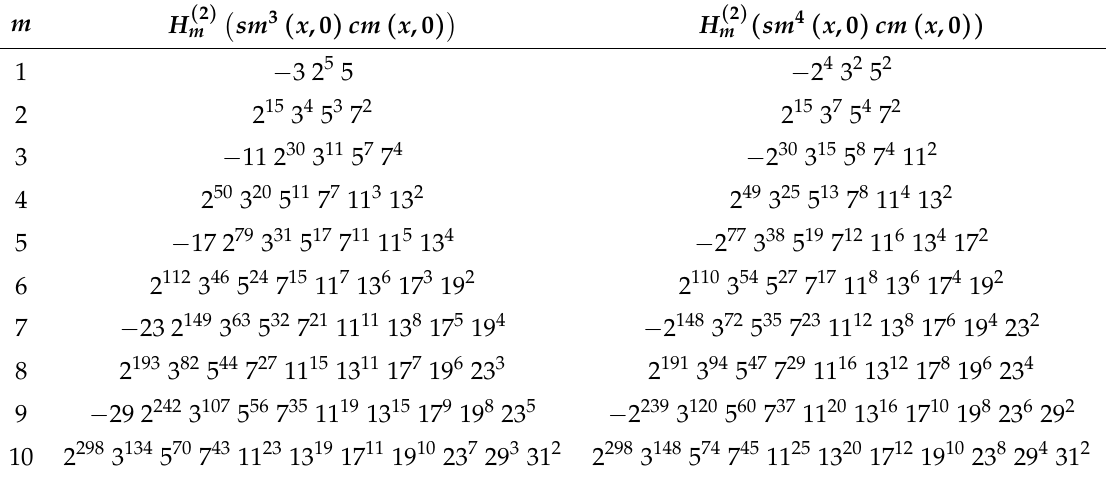
Table 5. Hankel determinants H sm 4 ( x ,0 ) cm ( x ,0 ) for m from 1–10.